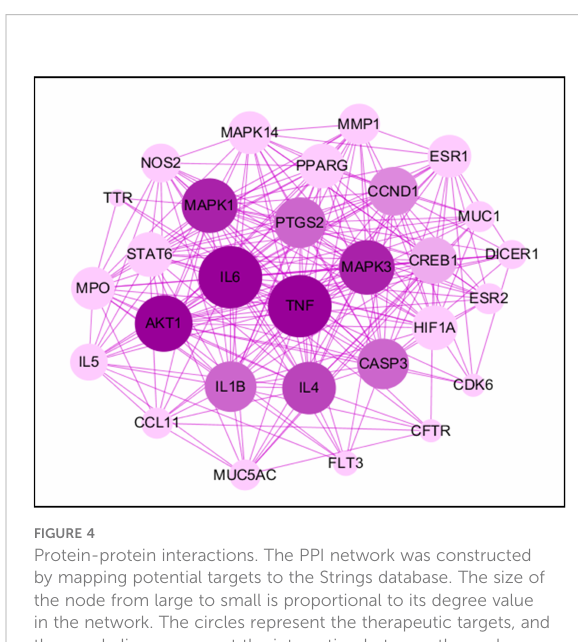
FIGURE 4 Protein-protein interactions. The PPI network was constructed by mapping potential targets to the Strings database. The size of the node from large to small is proportional to its degree value in the network. The circles represent the therapeutic targets, and the purple lines represent the interaction between the